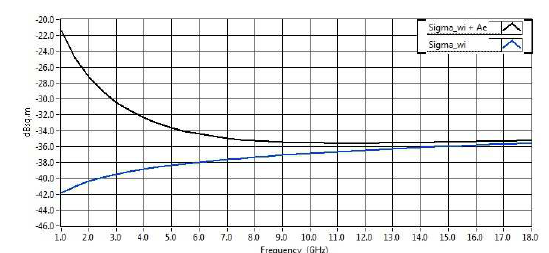
Figure 10: Expected results in dBsq.m. for s w,i + A e (black line) and s w,i , (blue line) for the enclosure with mesh size of 1 mm